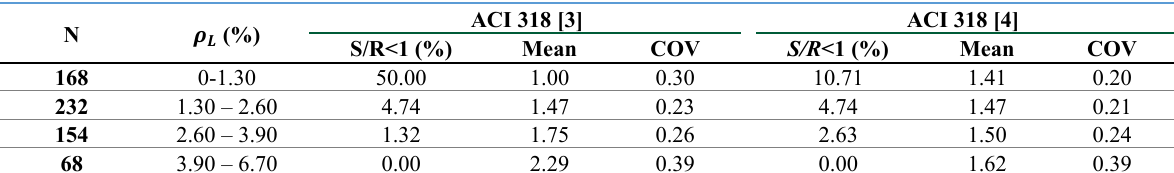
to ACI 318 [3] (yellow) and ACI 318 [3] (blue) 𝜌𝜌 𝐿𝐿